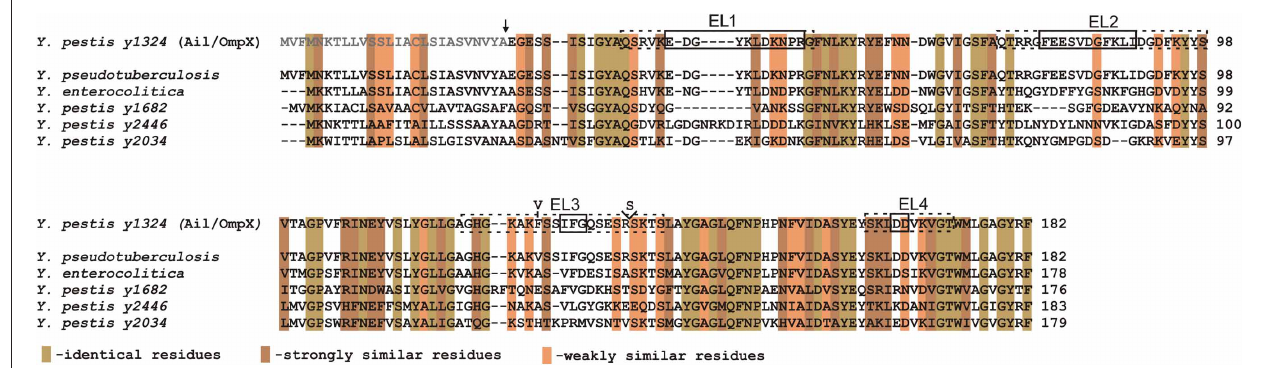
FIGURE 1 | Multiple strain sequence alignment and amino acid analysis of Ail. Gray letters indicate the signal sequence and the arrow indicates the signal sequence cleavage site (Kolodziejek et al., 2007). EL1, EL2, EL3, and EL4 designate extracellular loops; dotted line boxes indicate extracellular regions, including just the residues connecting two β strands (solid line boxes), as predicted from the crystal structure by Yamashita et al. (2011). Amino acid variation in the Ail polypeptide among Y. pestis strains is indicated by the presence of Val in the position 126 ( Y. pestis Pestoides F,